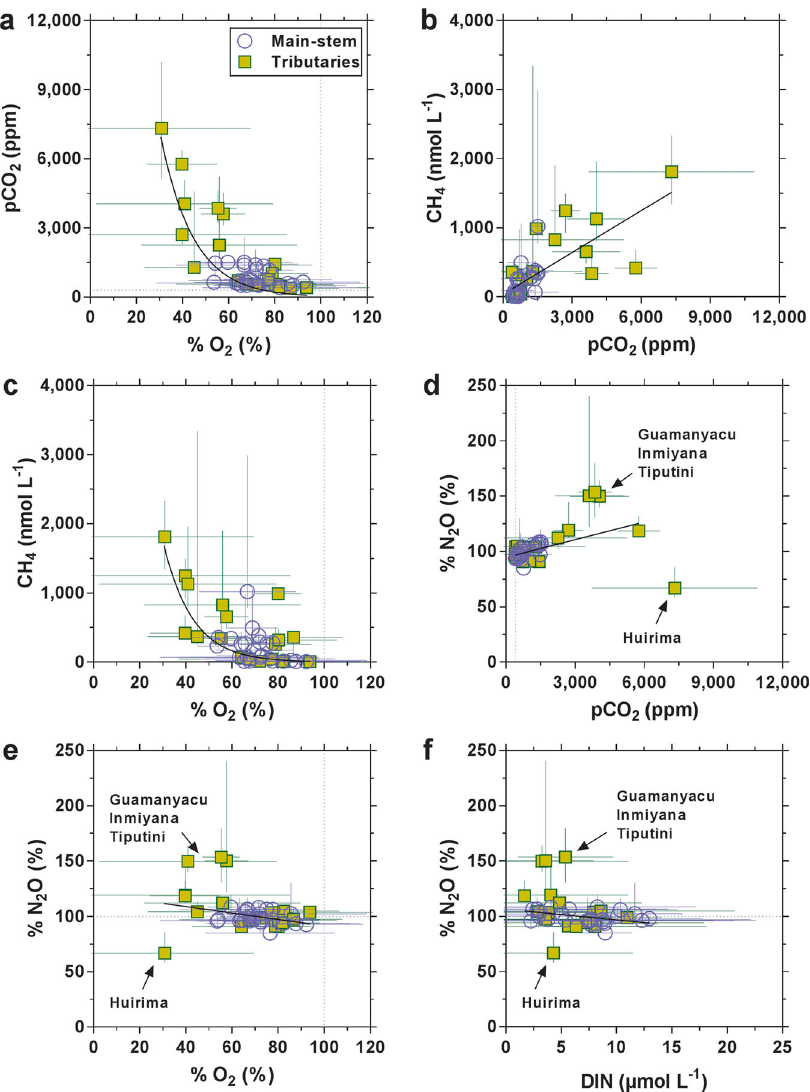
Fig. 3 Strong correlations between pCO 2 , CH 4 , %N 2 O and %O 2 in the Andean headwater and piedmont streams. Variations of the partial pressure of CO 2 (pCO 2 ), CH 4 dissolved concentration, N 2 O saturation level (%N 2 O), as a function of oxygen saturation level (%O 2 ) ( a , c , e ), CH 4 and%N 2 O as a function of pCO 2 ( b , d ), and %N 2 O as a function of dissolved inorganic nitrogen (DIN) ( f ) in the Napo streams. Symbols show the median and error bars the interquartile range, stations in the main-stem are shown by blue circles and in the tributaries by green squares, and black lines indicate linear or exponential fi ts to the data. Solid lines show fi ts to the data (Supplementary Table